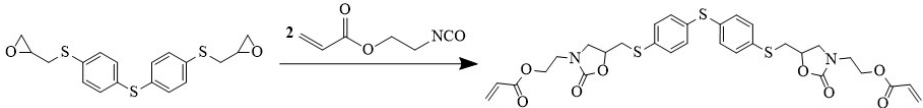
Figure 3. Synthesis of EA-UV photopolymer.